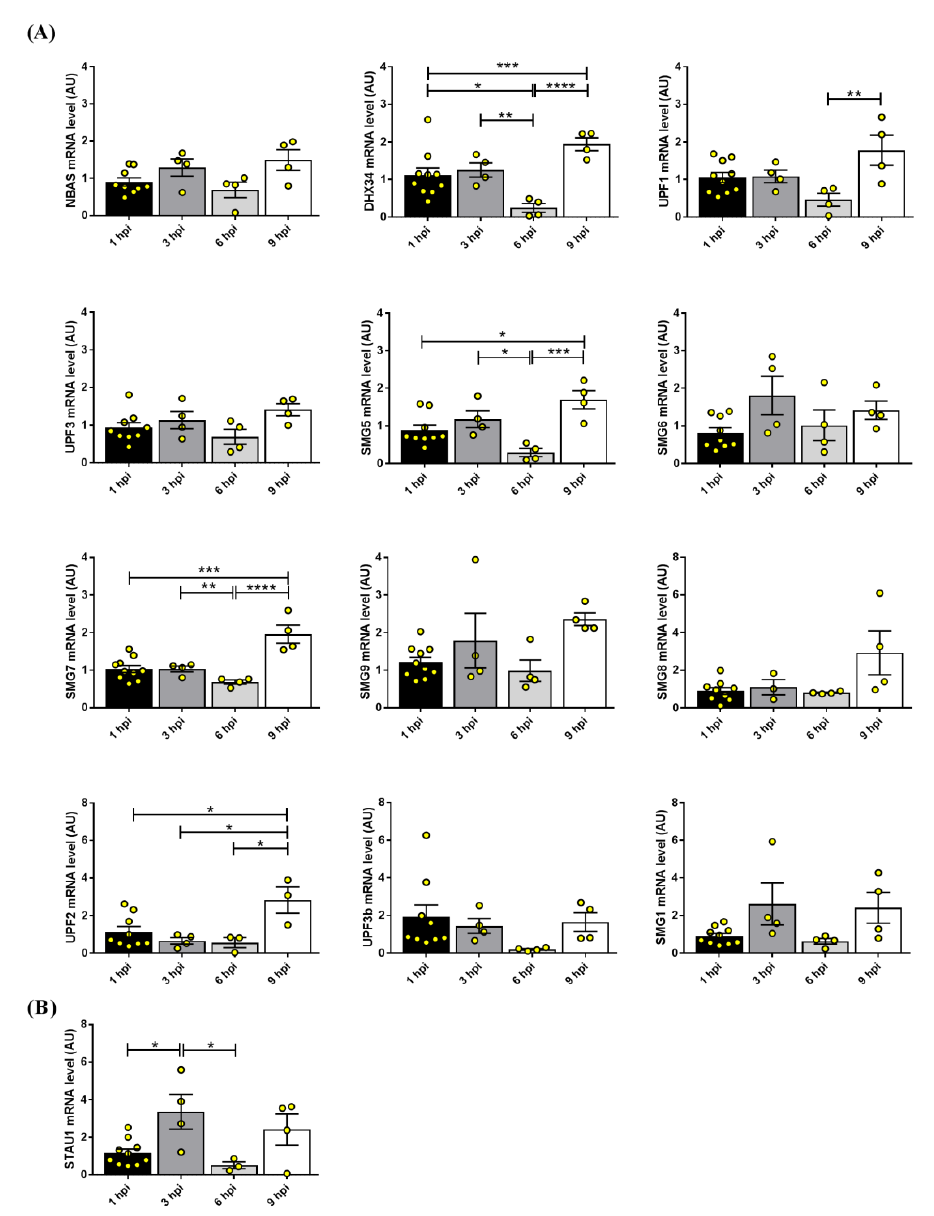
Figure 3. Gene expression analysis of NBAS and core genes of the NMD pathway ( A ) and STAU1 ( B ) during SARS-CoV-2 infection of Calu3 cells. Each bar represents the mean of at least four tech- nical replicates ± standard error of the mean (SEM); analysis of the outliers was performed using the ROUT method and Q =1%. Infected cells were compared with non-infected Calu3 cells for each time point. * p < 0.05, ** p < 0.01, *** p < 0.001, **** p < 0.0001. One-way ANOVA with the